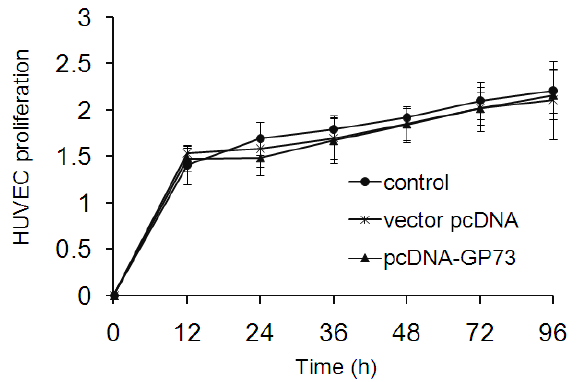
Figure 6. Effects of GP73 on the proliferation of vascular endothelial cells. Human umbilical vein endothelial cells (HUVECs) stably expressing GP73 were obtained as described in the methods section. Percentage of viability was obtained by comparing values to that of HUVECs in a control group. HUVECs proliferation variation was obtained by calculating the changes of HUVECs to baseline. Data was generated from HUVECs with three replicates and means ± SD values were